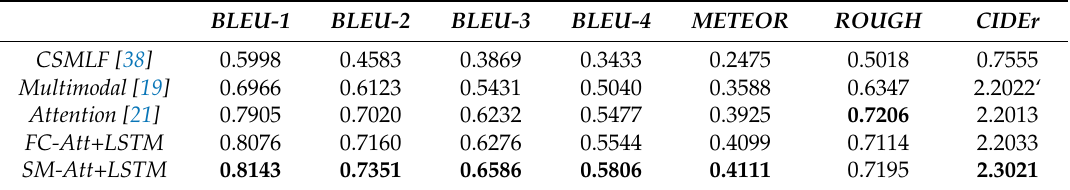
Table 1. Results of the baseline and our methods on the Sydney Dataset.